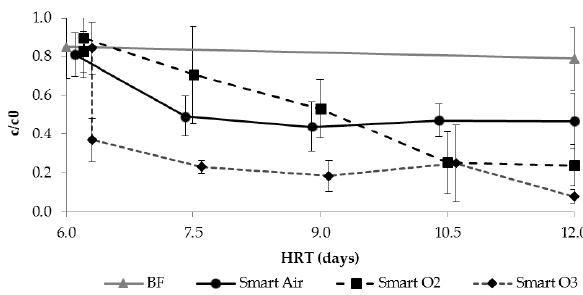
Figure 6. Degradation of gabapentin in the second filtration step of all four systems: BF, SMART air, SMART O 2 and SMART O 3 ( n ≥ 2).